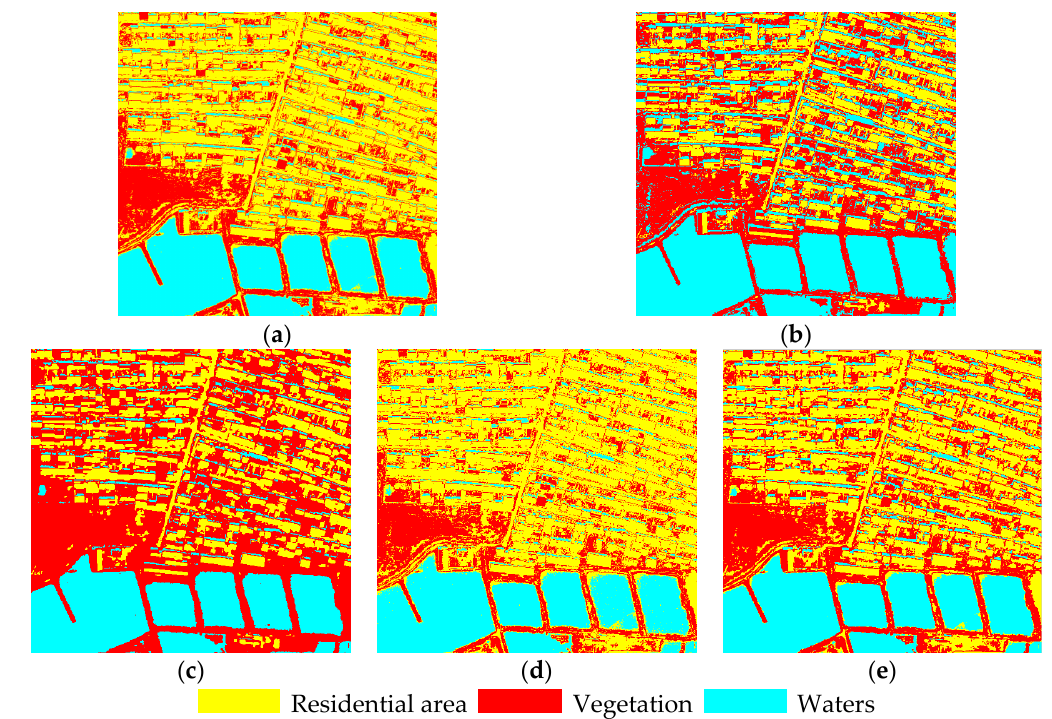
Figure 13. Word View-2 image classification results. ( a ) Maximum likelihood method; ( b ) FCM; ( c ) HMRF-FCM; ( d ) Weighted average method; and, ( e ) Neighborhood weighted average.